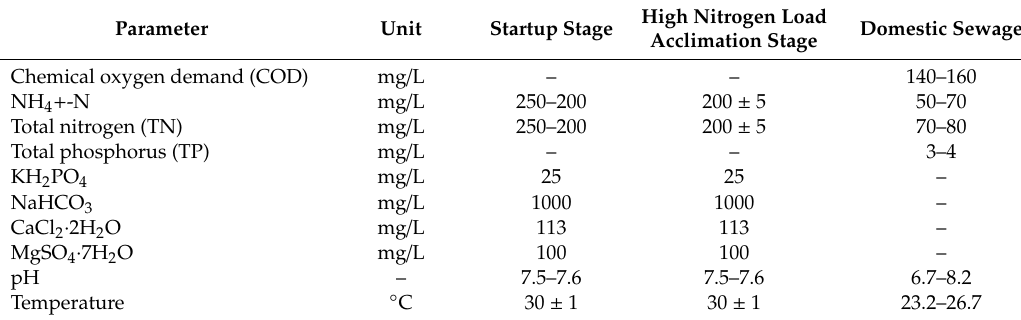
Table 1. Composition of